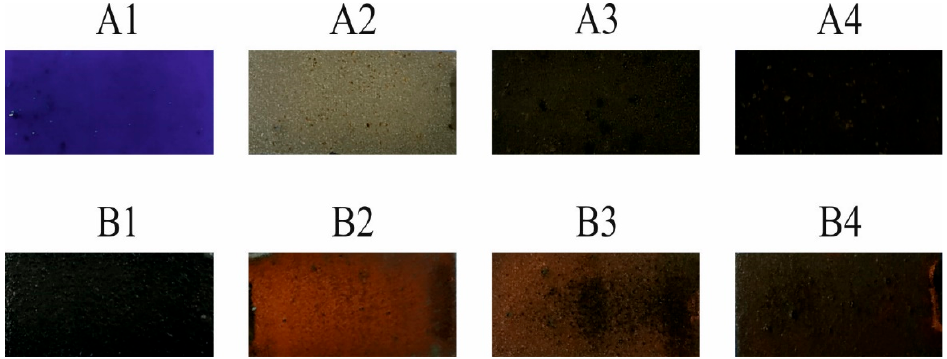
Figure 4. Images of irradiated and electroless metallized coatings.